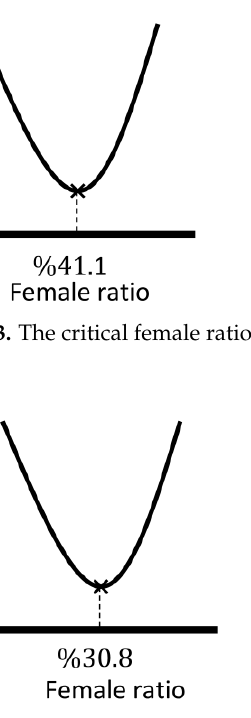
Figure 4. The critical female ratio in non-financial firms with respect to ROA.